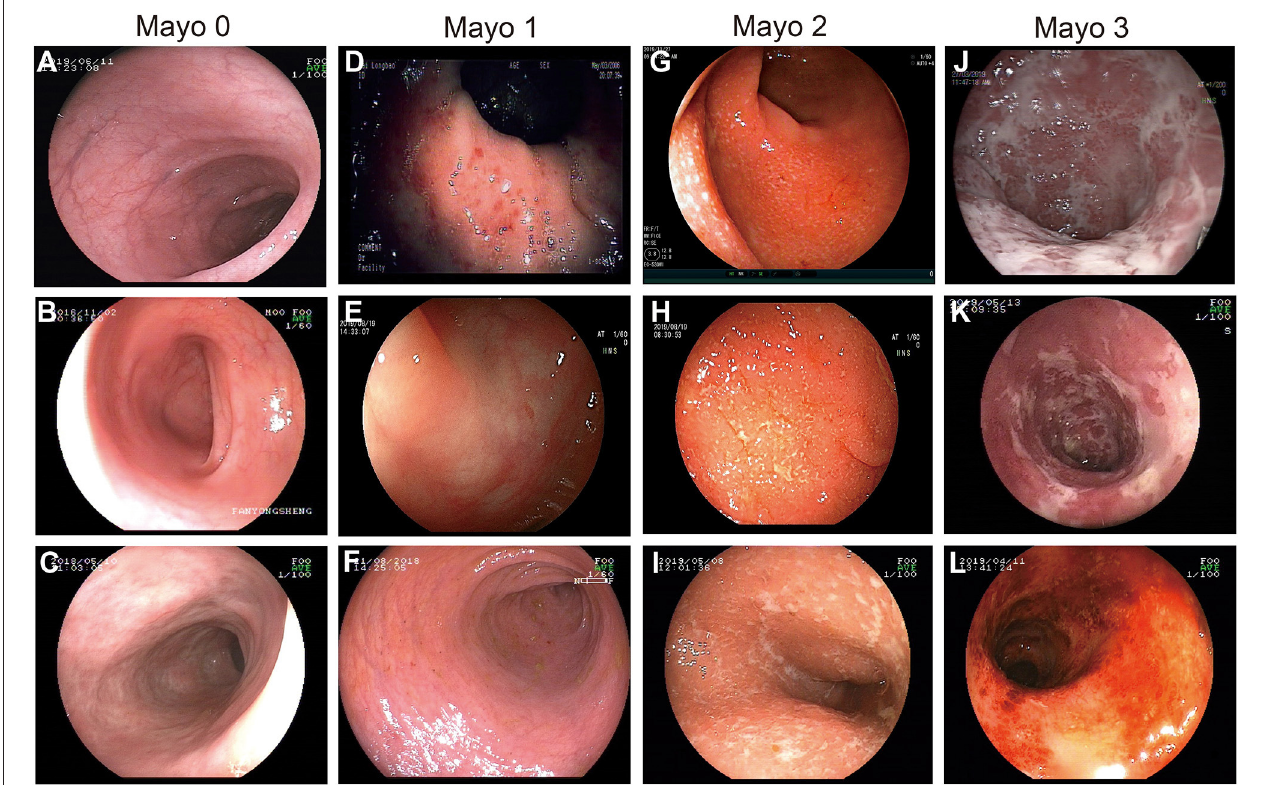
FIGURE 2 | Endoscopic images demonstrating the MES scoring system. (A–C) MES of 0: normal or inactive disease. (D–F) MES of 1: (D) mild disease with erythema, (E) decreased vascular patterns, (F) mild erosion. (G–I) MES of 2: absence of vascular patterns, and erosions. (J–L) MES of 3: (J,K) serious ulceration and (L) spontaneous